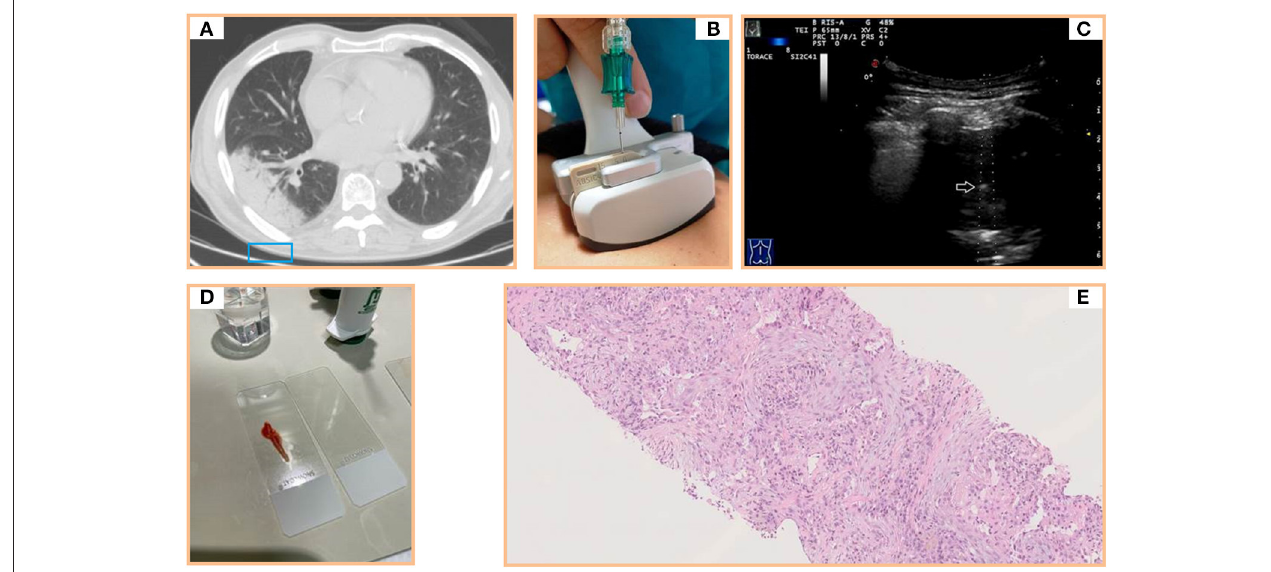
FIGURE 2 | (A) Axial chest computed tomography (CT) showing a subpleural pulmonary lesion with inner air bronchograms in the lower right lobe. (B) Dedicated ultrasound convex transducers with a central hole for needle set insertion during US-guided biopsy procedure. (C) Transthoracic ultrasound scan (TUS) using the dedicated convex probe (3.5–8 MHz) during US-guided biopsy (corresponding to the blue box in A) allowing real-time visualization of the needle (white arrow) in a hypoechoic subpleural lung lesion. (D) Specimen suitable for histological and cytological diagnosis. (E) Histological examination of a sample from the lesion (hematoxylin and eosin) revealing a mixture of inflammatory cells and fibroblastic plugs within airspaces.